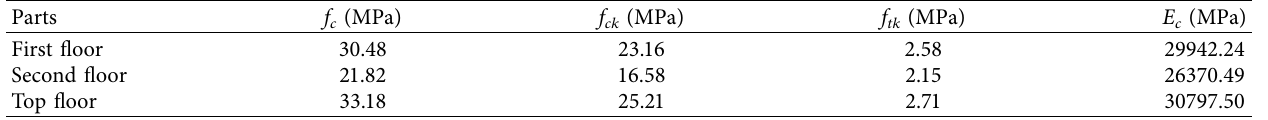
Table 1: Concrete properties in different